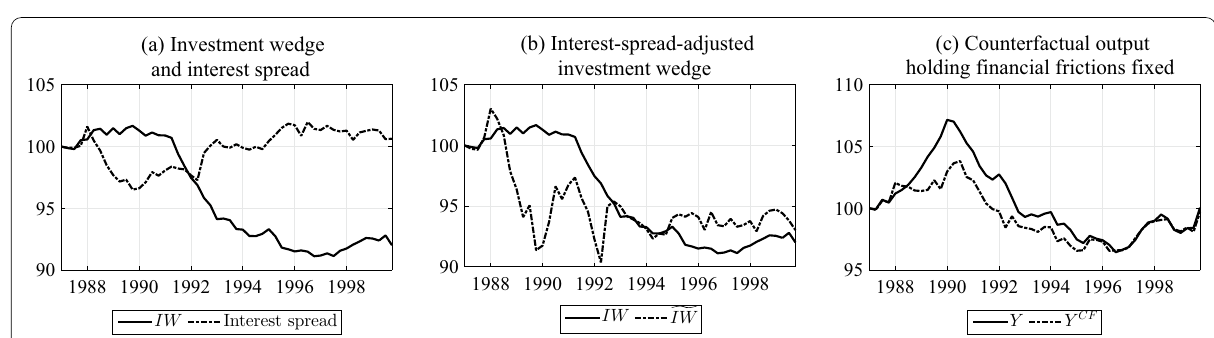
Fig. 19 Robustness: The role of disruptions in financial intermediation for ν = 2 (1987Q1–1999Q4). IW denotes the investment wedge, the interest spread corresponds to the spread between the lending and deposit rates obtained from the IMF International Financial Statistics, and interest-spread-adjusted investment wedge. Y is output and Y CF denotes the counterfactual path of output when holding financial frictions fixed